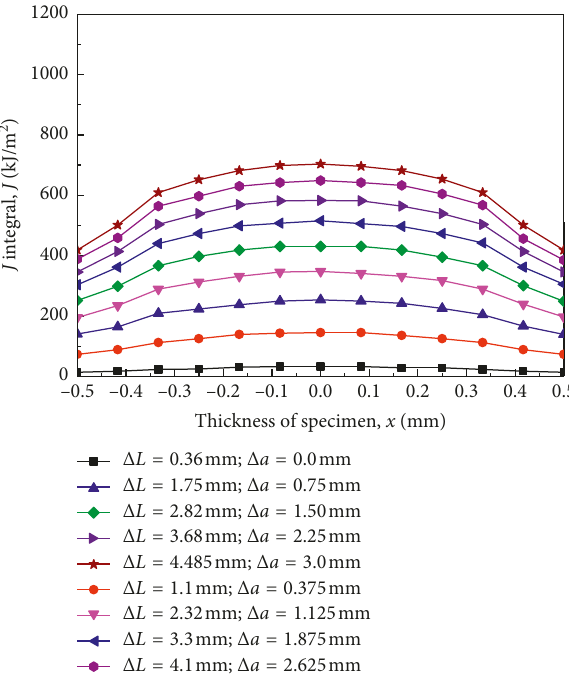
a , and L data. Δ Figure 9: The stress intensity factor K specimen.